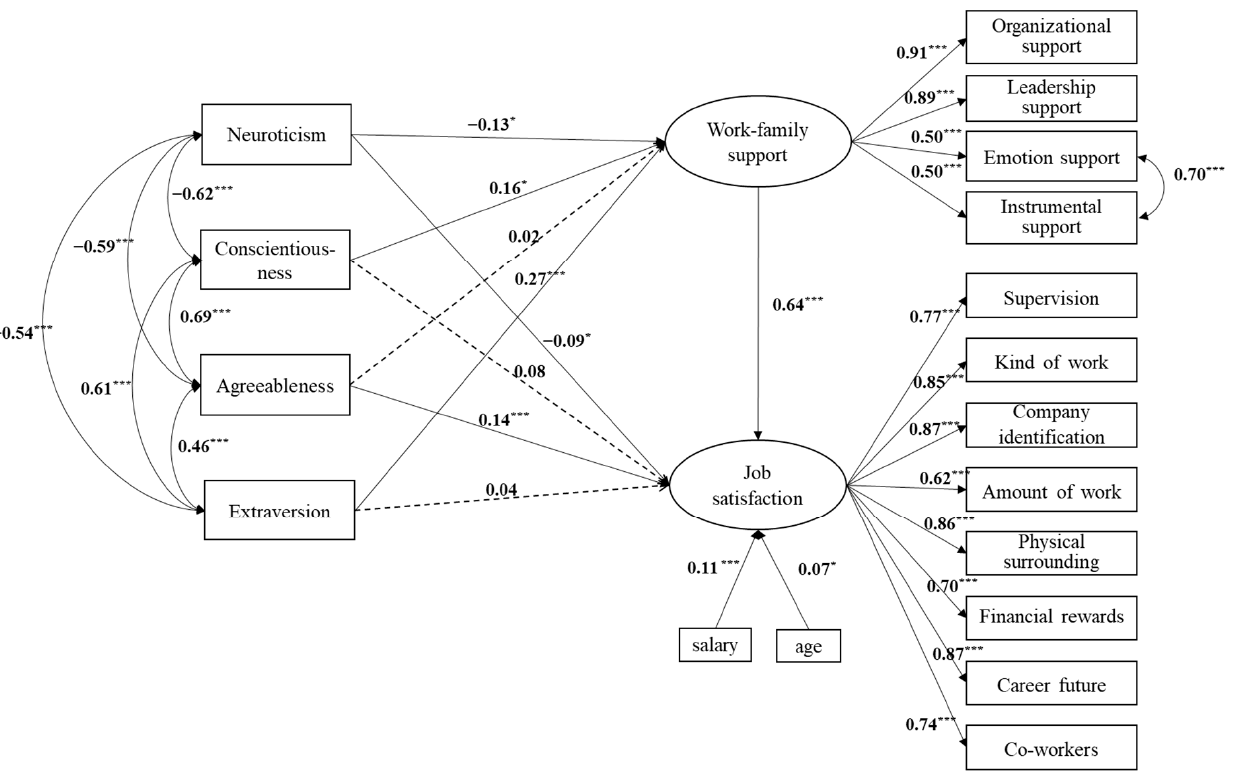
Figure 1. Structural model with standardized path loadings. Note: solid line = path differing significantly from 0; dashed line = path not differing significantly from 0. * p < 0.05, *** p < 0.001. For personality traits and WFS, neuroticism ( β = − 0.130, p < 0.05), conscientiousness ( β = 0.16, p < 0.05), and extroversion ( β = 0.27, p < 0.001) were all found to have a significant influence on WFS. These results indicated that frontline power grid workers with low neuroticism, high extroversion, and conscientiousness are more likely to experience WFS. For personality traits and JS, neuroticism ( β = − 0.09, p < 0.05) and agreeableness ( β = 0.14, p < 0.001) were found to have a significant influence on JS and indicated workers with low neuroticism and high agreeableness were more likely to experience JS. Moreover, WFS ( β = 0.64, p < 0.001) had a positive influence on JS and indicated workers with higher WFS tend to be more satisfied with their job. The control variables, age ( β = 0.07, p < 0.05) and salary ( β = 0.11, p < 0.001), were both found to have significant relationships with JS. The result of bootstrap analysis suggested WFS partially mediates the effect of neuroticism on JS and fully mediates the effect of conscientiousness and extraversion on JS. However, the relationship between agreeableness and WFS had no statistical significance, so WFS was not a mediator between them. More details can be seen in Table 4.